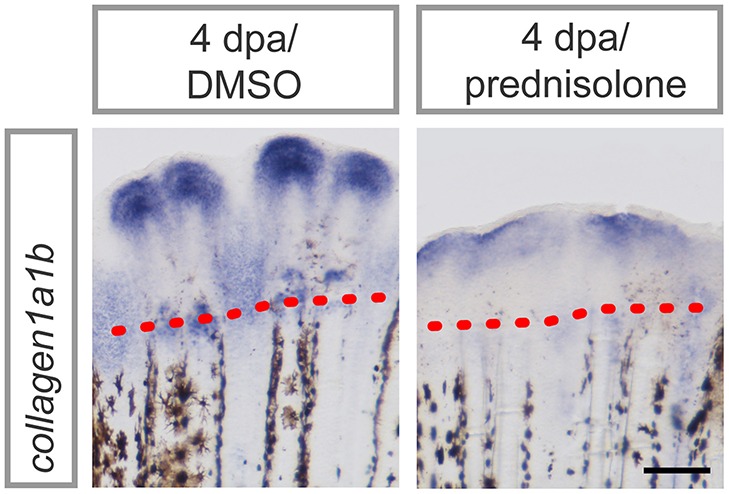
col1a1b expression in prednisolone treated fins at 4 dpa. Scale bar 200 μm. n = 4.